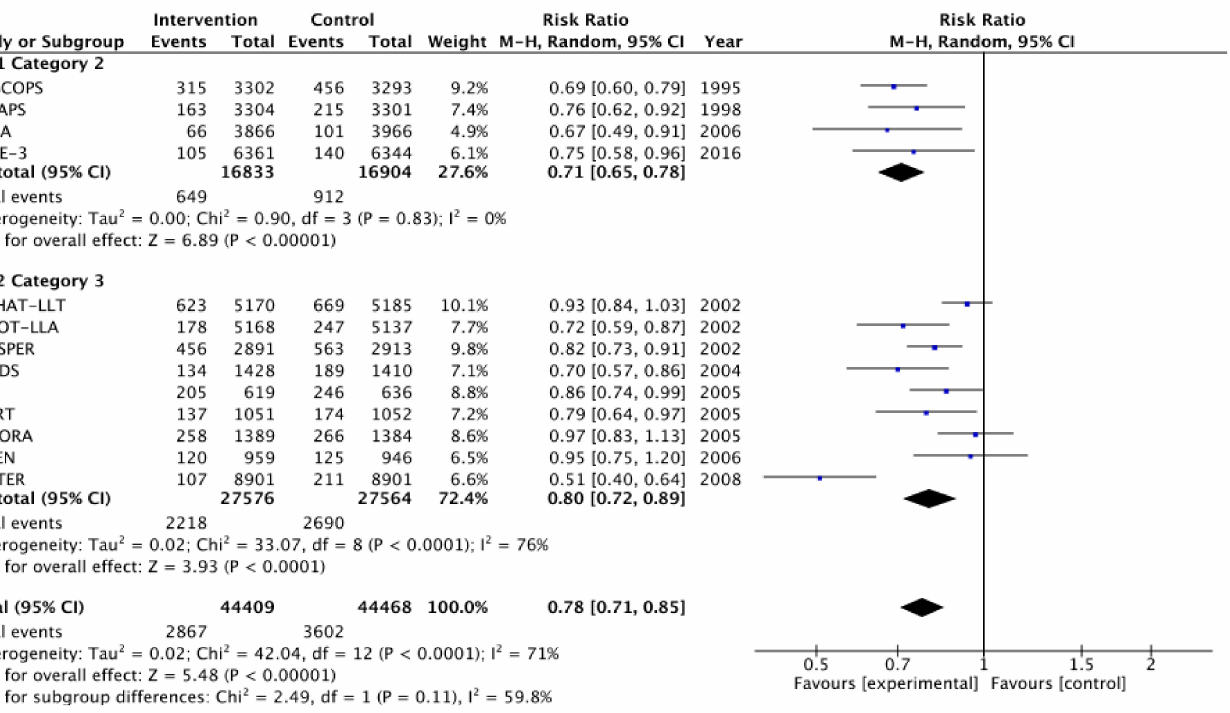
Figure 4. Relative risk across Category 2 and 3 studies for the secondary outcome of all CHD events combined. Heterogeneity across studies was high, so random effects were sed for the meta-analysis (Heterogeneity: Chi 2 = 42.04, p < 0.001, I 2 = 71%).